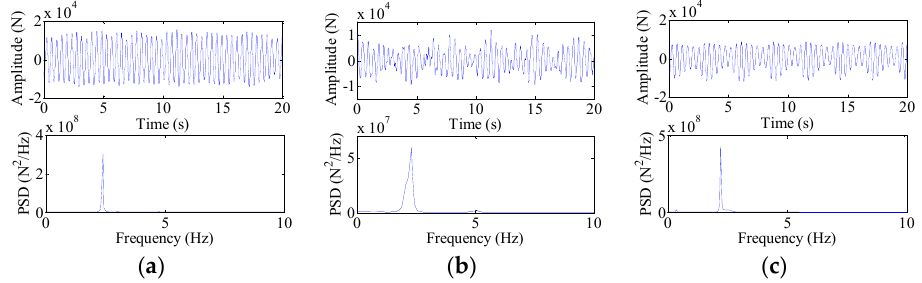
Figure 6. Total aerodynamic forces acting on the wind rotor: ( a ) Average value; ( b ) RMS amplitude.